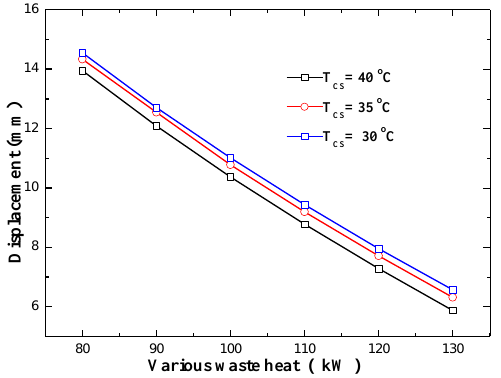
Figure 19. Displacement of suction slide valve vs. various waste heat.